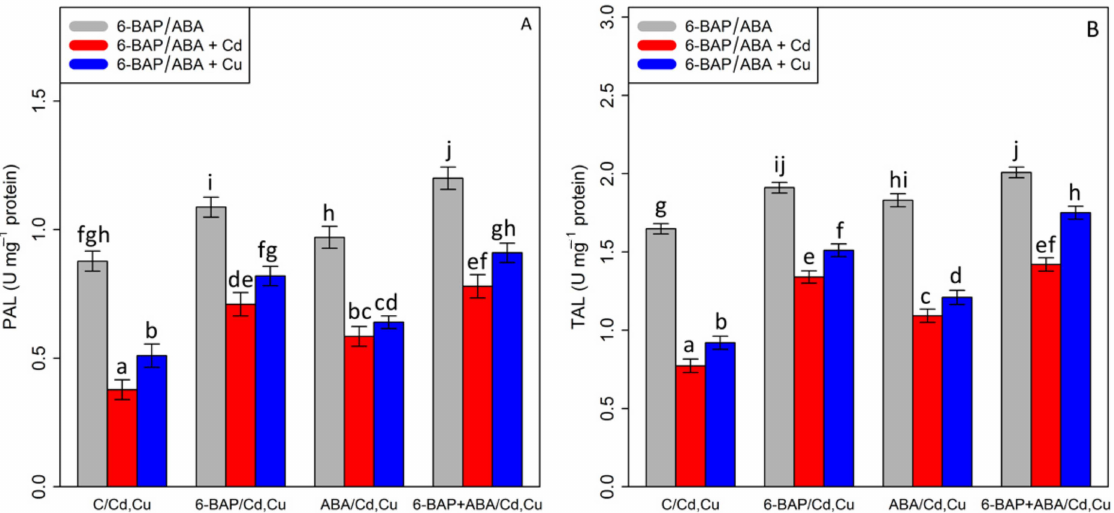
Figure 7. The impact of 6-benzylaminopurine and abscisic acid, alone and in combination, on ( A ) phenylalanine ammonia-lyase (PAL) activity and ( B ) tyrosine ammonia-lyase (TAL) activity in one-year-old Pleioblastus pygmaeus exposed to 100 µ M Cd and 100 µ M Cu. In this figure, a, b, c, etc. letters revealed significant differences between control, 6-BAP, ABA, 6-BAP + ABA, in both combined and single form, with 100 µ M cadmium and 100 µ M copper based on Tukey’s test ( p <